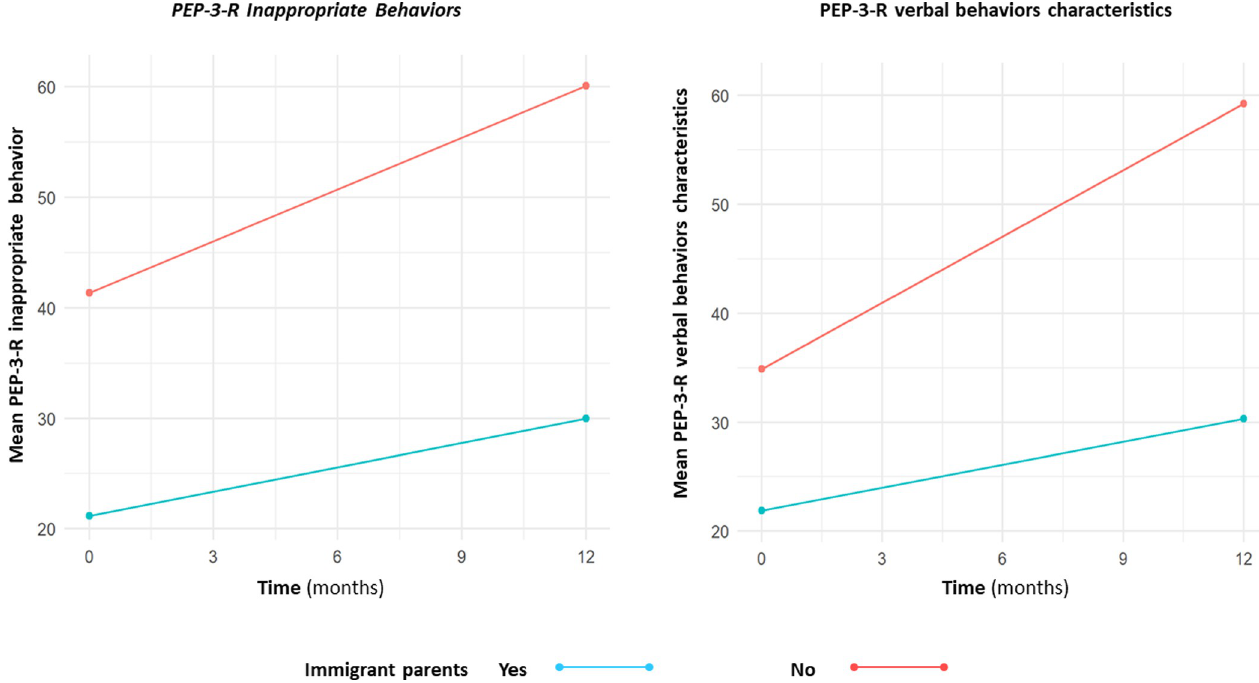
Fig 4. Evolution of inappropriate PEP-3-R behaviors and PEP-3-R verbal behaviors characteristic of a negative interaction between course over time and family migration status during the 12-month follow-up.